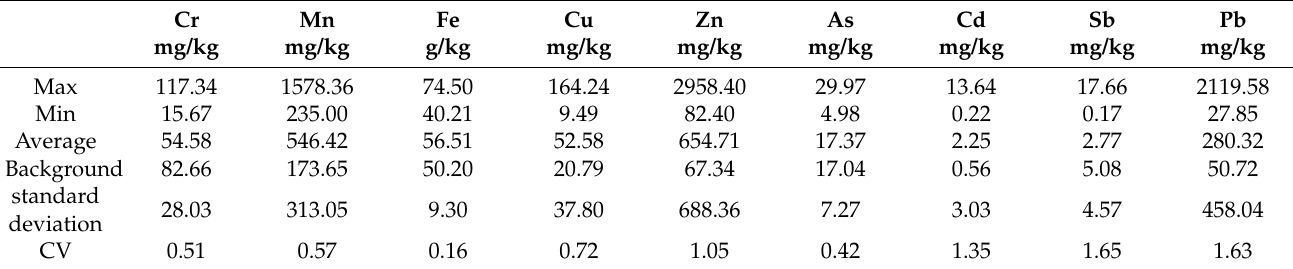
Table 2. Statistical table of HMs content in study area ( n = 40).